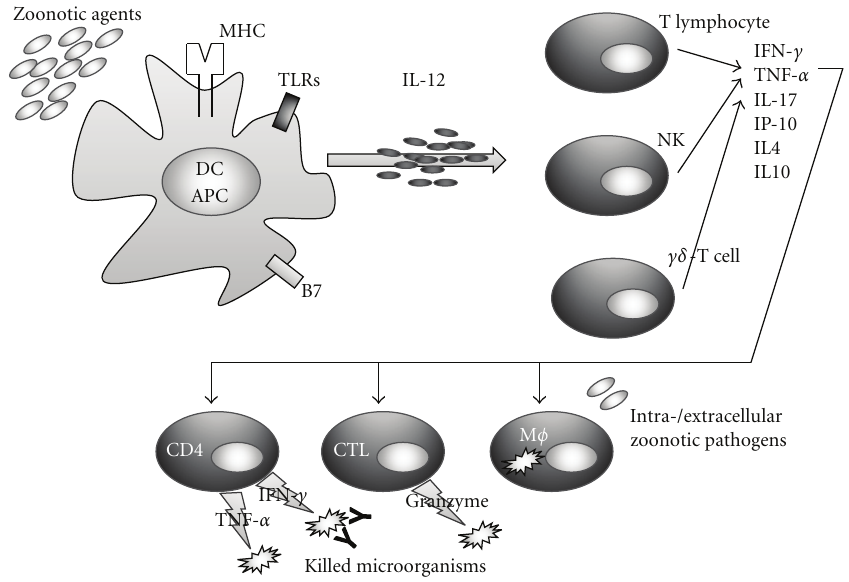
Figure 1: Schematic network of cells and molecules in response to zoonotic agents. An “oversimplified” scenario constituted by various cells and molecules involved both in binding of epitopes derived from pathogens and in the e ff ector mechanisms hereby represented. APCs bind zoonotic derived epitopes and present them to various types of lymphocytes, in the context of MHC molecules and/or Toll-Like Receptors (TLRs). These subsets, producing di ff erent cytokines, could activate e ff ector “protective” mechanisms involving macrophage killing, cytotoxic activity by CTL and/or CD4, and release of various cytokines, thus leading to the damaging of zoonotic pathogens. The killing by CTL, that could be not only CD8 but also NK cells, could be also due to an ADCC phenomenon with the contribution of antizoonotic epitopes,-specific